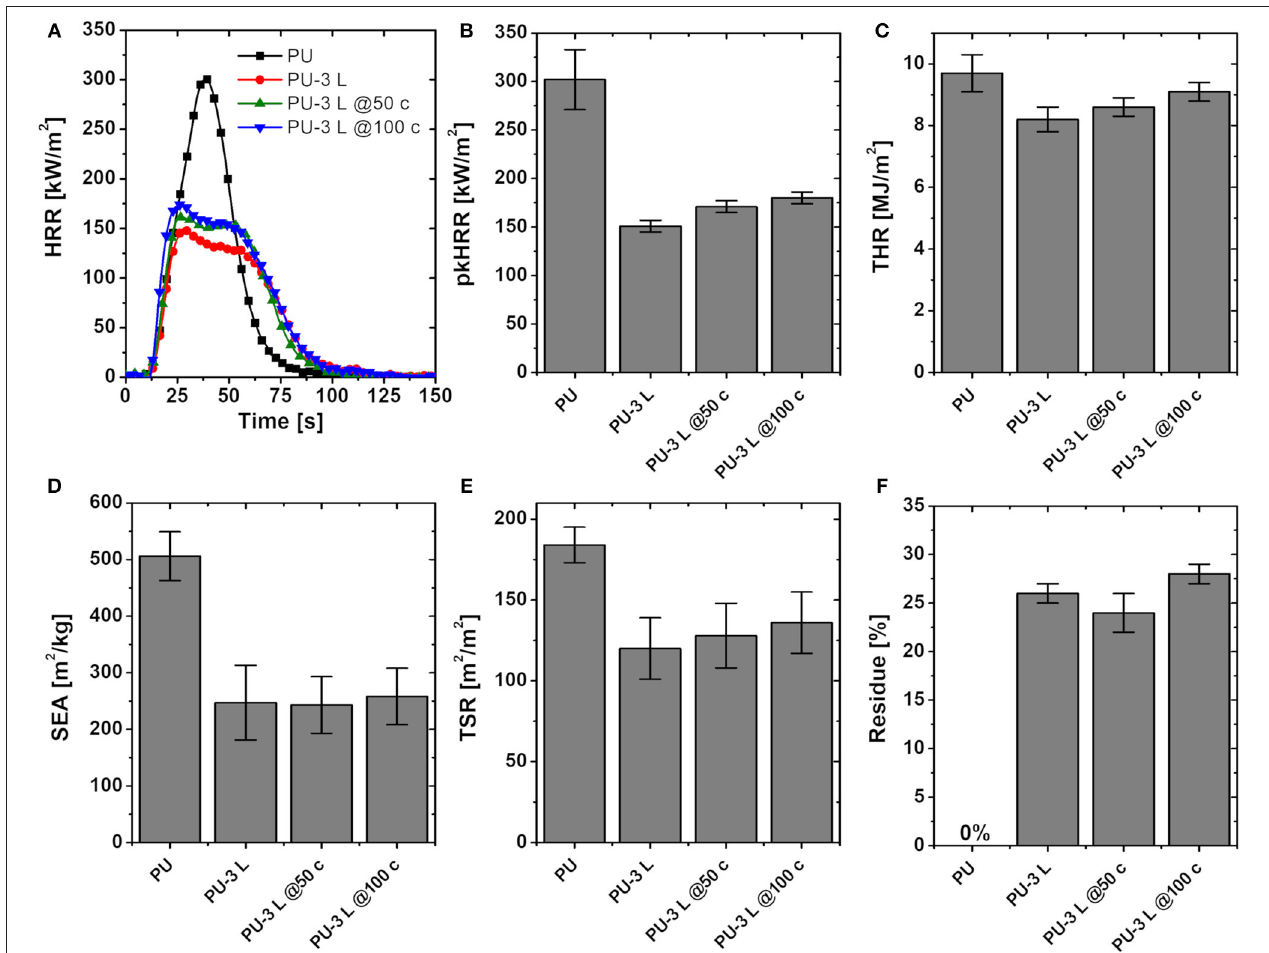
FIGURE 5 | Cone calorimetry parameters neat PU, treated PU, and treated PU foams after compression cycles: (A) HRR vs. time plot, (B) peak of heat release rate (pkHRR), (C) total heat release (THR), (D) average specific extinction area (SEA), (E) total smoke release (TSR), and (F) final residue.